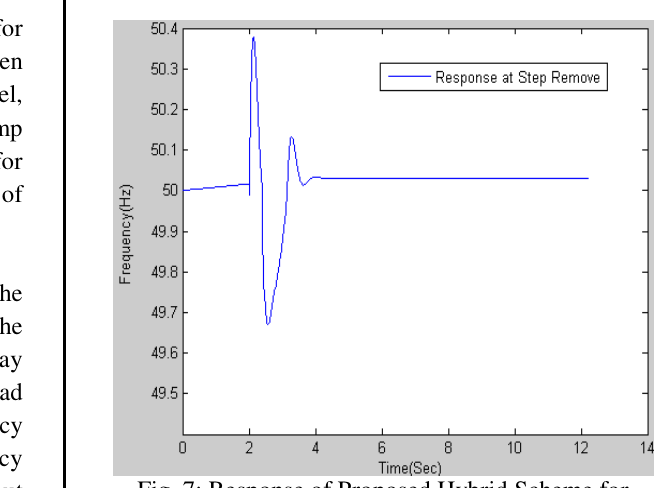
Fig. 7: Response of Proposed Hybrid Scheme for SHP at Step